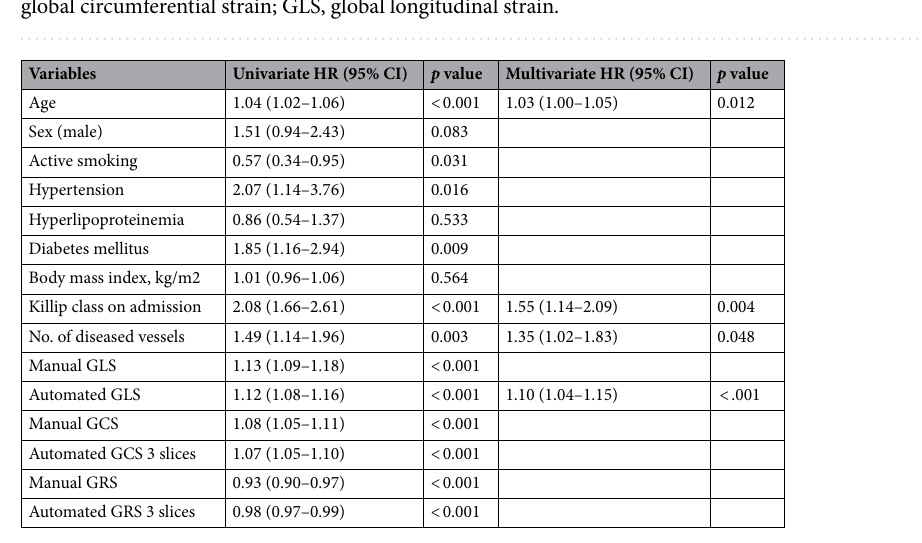
Table 4. Univariate and multivariate Cox regression analysis. Multivariate analysis including automated GLS, GCS 3 slices and GRS 3 slices. Univariate and multivariate analysis represented by HR and 95% CI. Univariate significant parameters ( p < 0.05) were included in multivariate analysis. Considering high correlation of automated and manual analyses, multivariate analyses were based on automated strain analyses only. GCS, global circumferential strain; GLS, global longitudinal strain; GRS, global radial strain; HR, hazard ratio; CI, confidence interval. Results of multivariable modelling including manual GLS but not automated strain is reported elsewhere 7